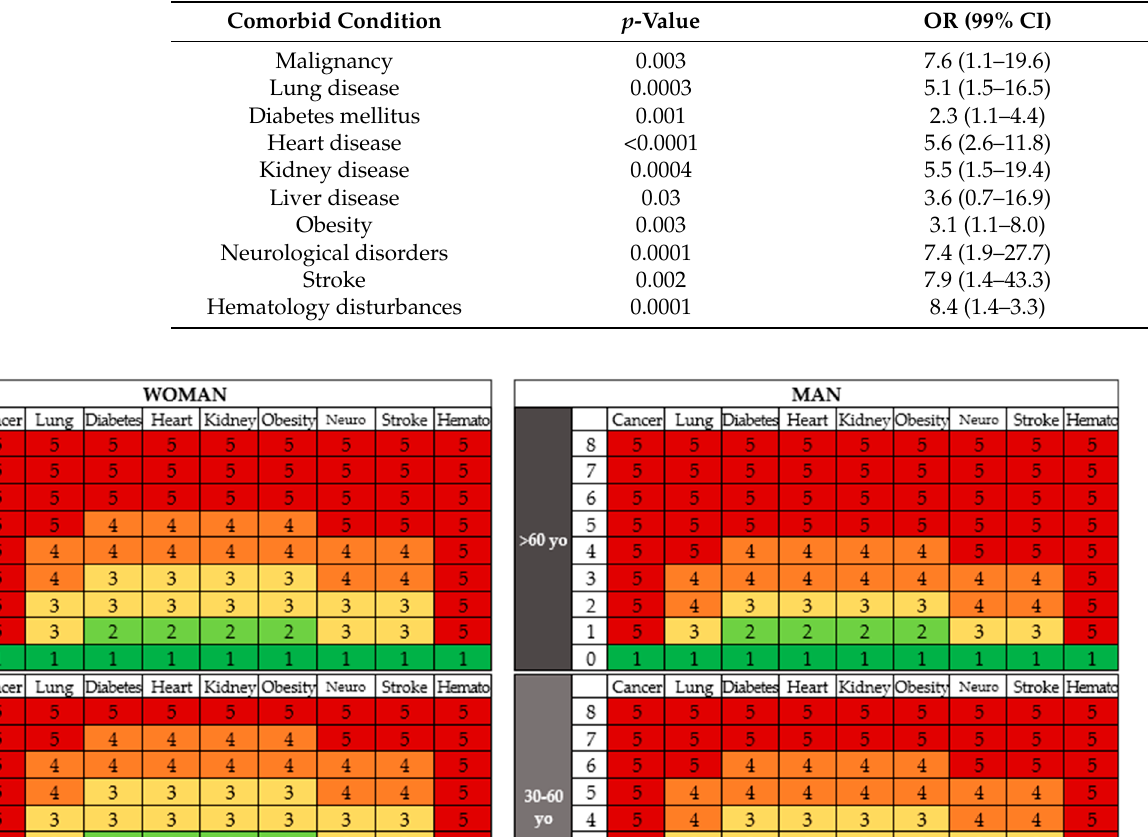
Table 3. Risk matrix predictors.